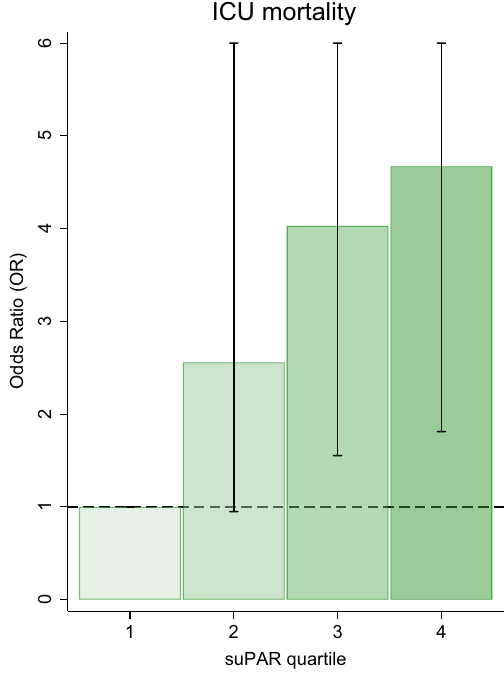
Figure 2. Association of ICU mortality with suPAR quartiles. The highest compared to the lowest quartile of suPAR had an odds ratio (OR) of 4.7 for ICU mortality. In the figure, the upper border of the confidence interval was truncated at the OR of 6.